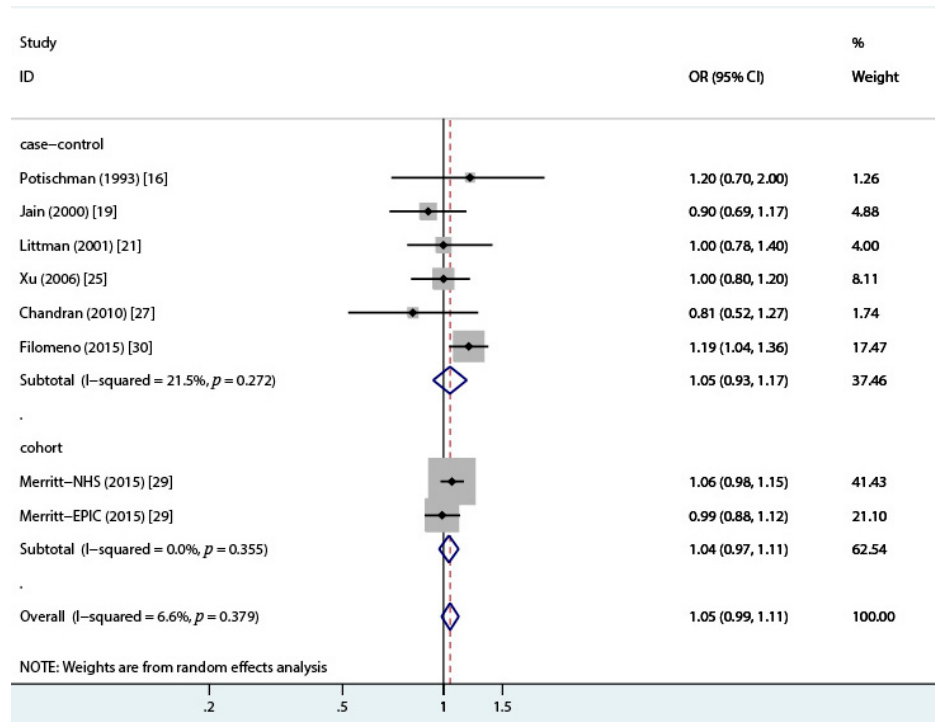
Figure 4. Egger’s regression asymmetry test of the meta-analysis for the association between total dairy intake and risk of endometrial cancer.